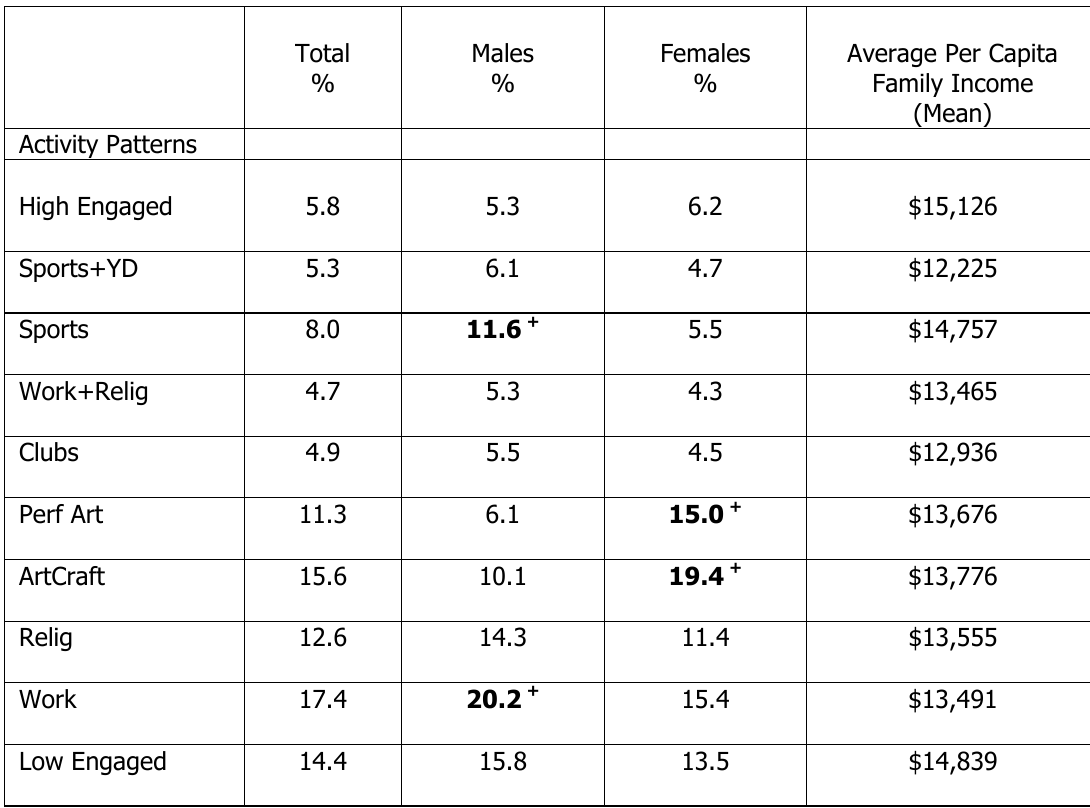
Percentage of youth who participate in each activity pattern by gender and family